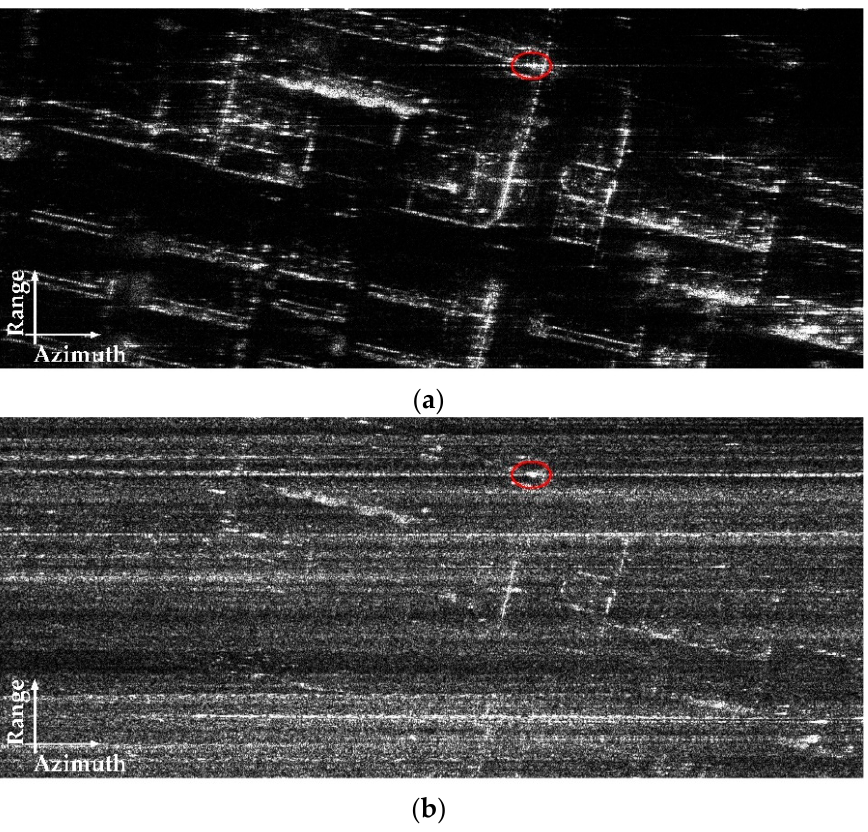
Figure 12. Panorama of the observed scene.